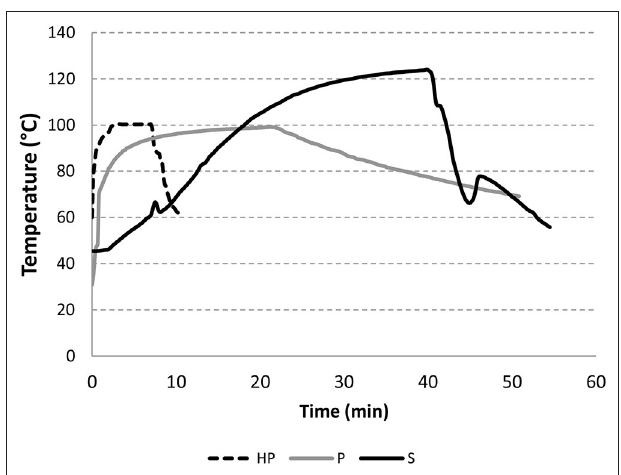
FIGURE 2 | Evolution of temperature during pasteurization (P), sterilization (S) and home-made (HP)